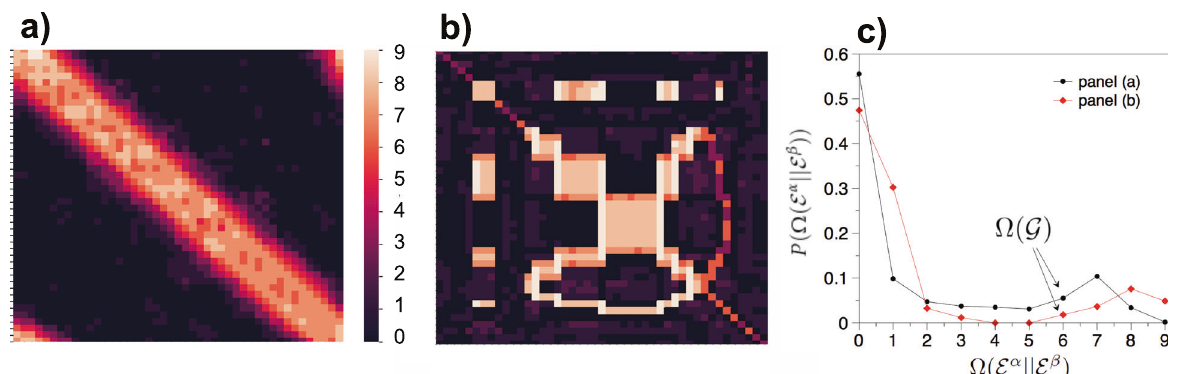
Fig. 1 Shape of memory and emergence of virtual loops in temporal networks with correlated link dynamics. A temporal fully connected network G with N = 10 nodes and L = 45 links whose dynamics are both autocorrelated and heterogeneously cross-correlated, generated from an eCDARN( p ) model with parameters q = 0.9, y = 0.5, c = 0.7 and a set of memory lengths p randomly sampled with uniform (panel ( a )) or a bimodal (panel ( b )) probability from {0, 1, … , 6} (see SI section IVA for details). a The 45 × 45 entries of the co-memory matrix M (shown with a colour code) display the shape of the network memory at the microscopic scale of pairs of links. In this speci fi c case the eCDARN( p ) model is chosen such that the causal structure of link dependencies is restricted in a Bayesian ring topology of L = 45 nodes, so that when link α samples its activity from the past history of other links, it randomly samples from α ± 1. The scalar memory of the network is Ω ð G Þ ¼ 6. Pairs of neighbouring or close links in the Bayesian ring exhibit high memory co-order, often above Ω ð G Þ , due to the onset of virtual loops (see the text), whereas distant links are seldom cross-correlated and thus display low co-order memory. b Similar to ( a ), but where the link ’ s causal structure is given by a different Bayesian graph (see SI section IVA for full details). A notably different memory shape emerges, however the scalar memory of the network is still Ω ð G Þ ¼ 6. c Distribution of memory co-orders in both examples, showing different heterogeneous pro fi les which in both cases are not well characterised by Ω ð G Þ